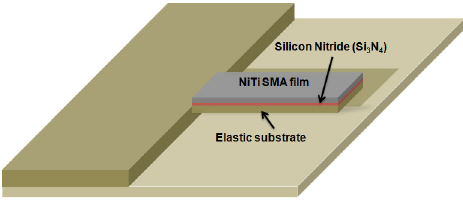
Figure 1. A schematic layout of NiTi/elastic substrate composite nanocantilever.